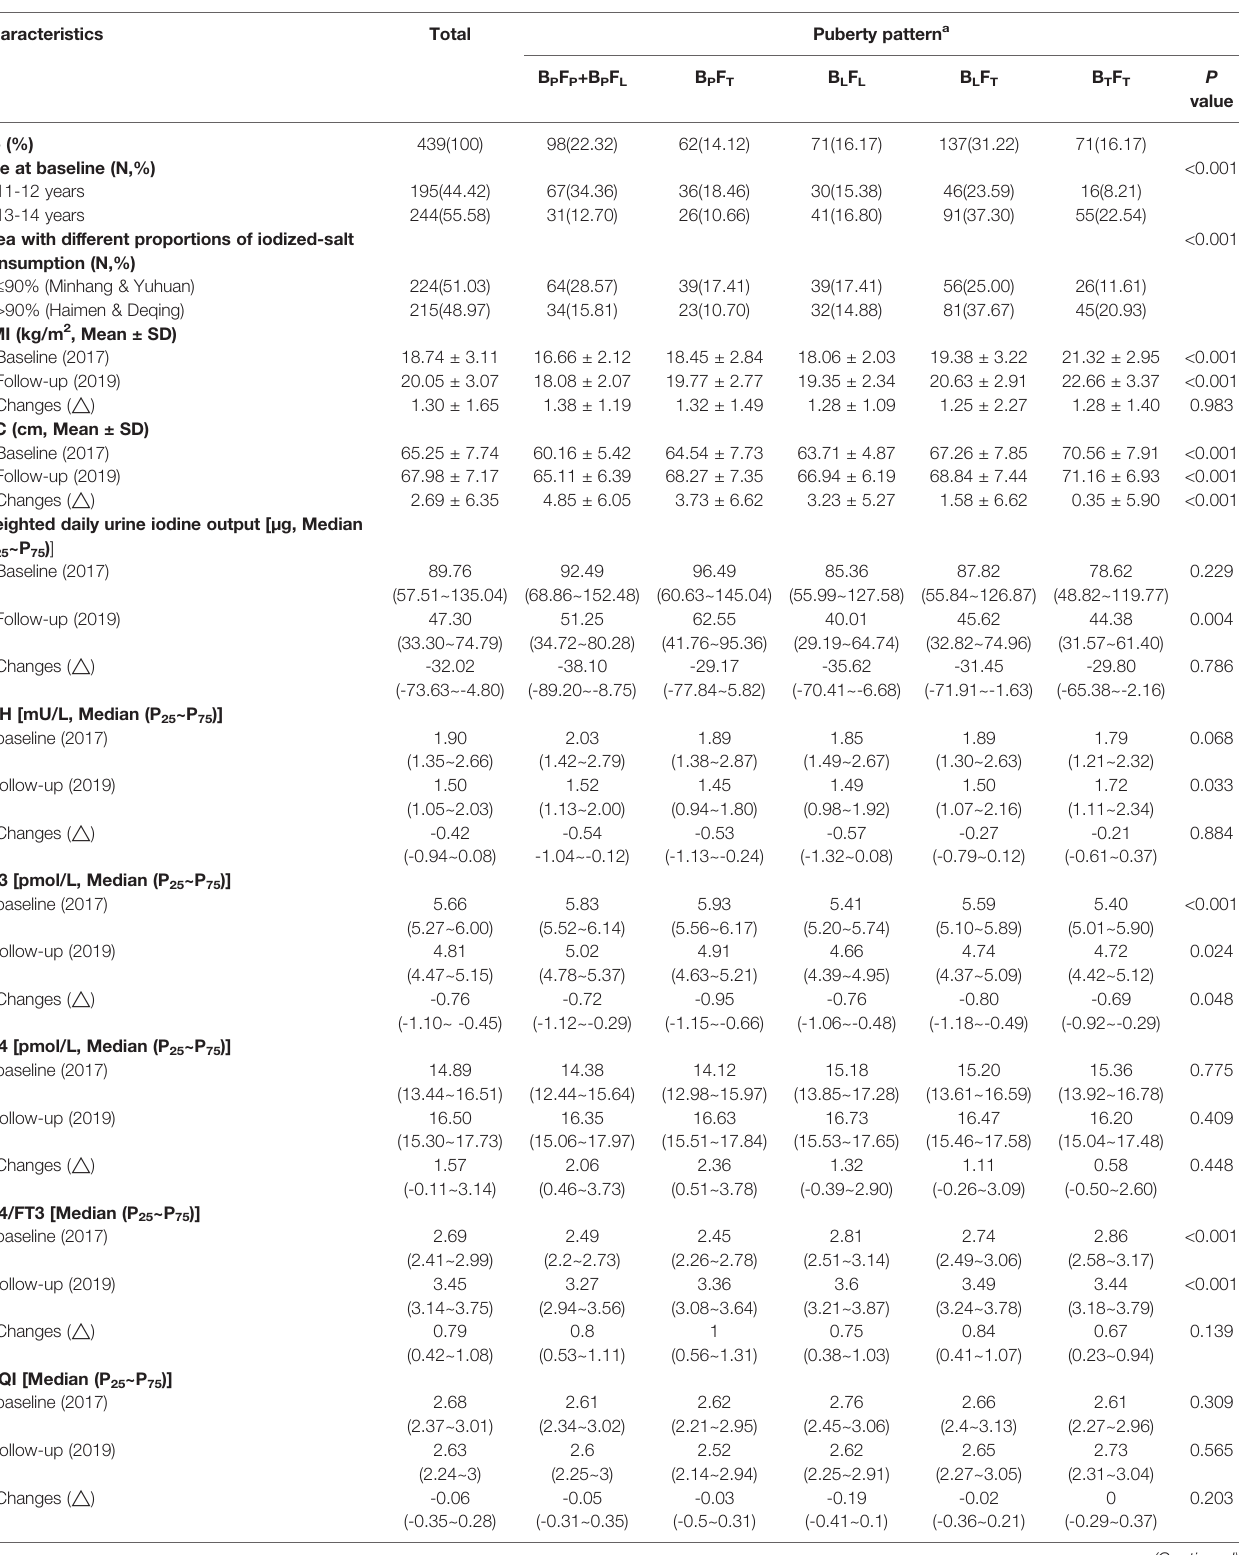
TABLE 2 | Characteristics, anthropometric indexes, thyroid hormones (THs), and thyroid homeostasis structure parameters (THSPs) of girls with different puberty patterns.